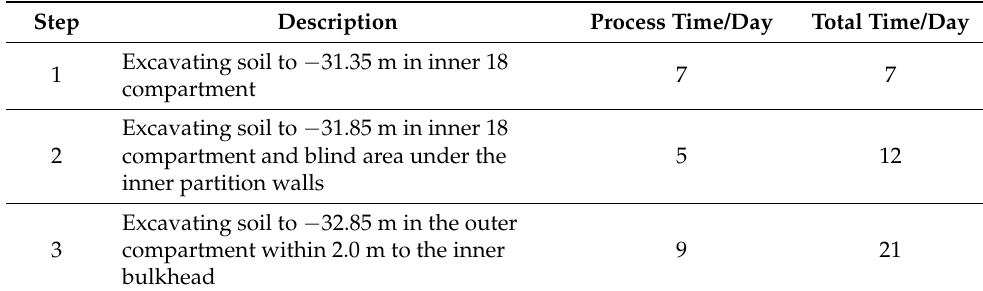
Figure 8. Schematic diagram of soil excavation steps at the first stage. Table 2. soil excavation at the first stage.